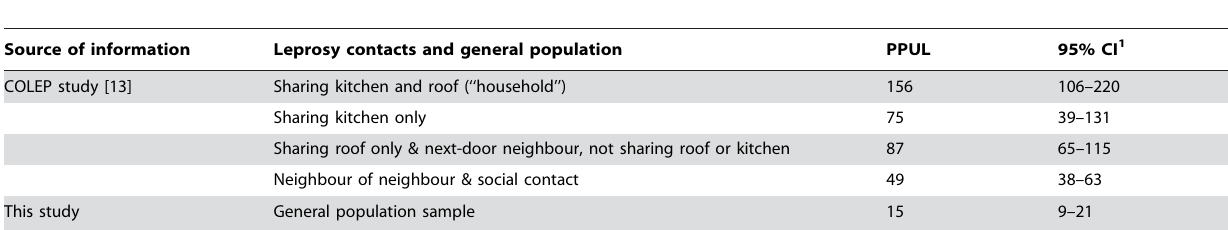
Table 3. Prevalence of previously undiagnosed leprosy (PPUL) per 10,000 in the subgroups of the contact population of the COLEP study [13] and in the general population